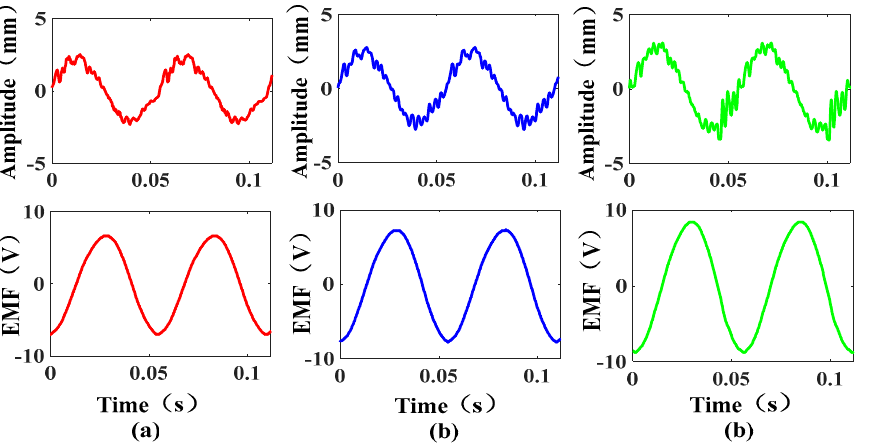
Figure 15. Effect of the excitation amplitude on the EMF: ( a ) 2.5 mm; ( b ) 2.8 mm; ( c ) 3.1 mm. According to the experimental results, the peak values of the output EMF from left to right are 6.6 V, 7.8 V, and 8.8 V, which are increased by 18.1% and 12.8%, respectively.